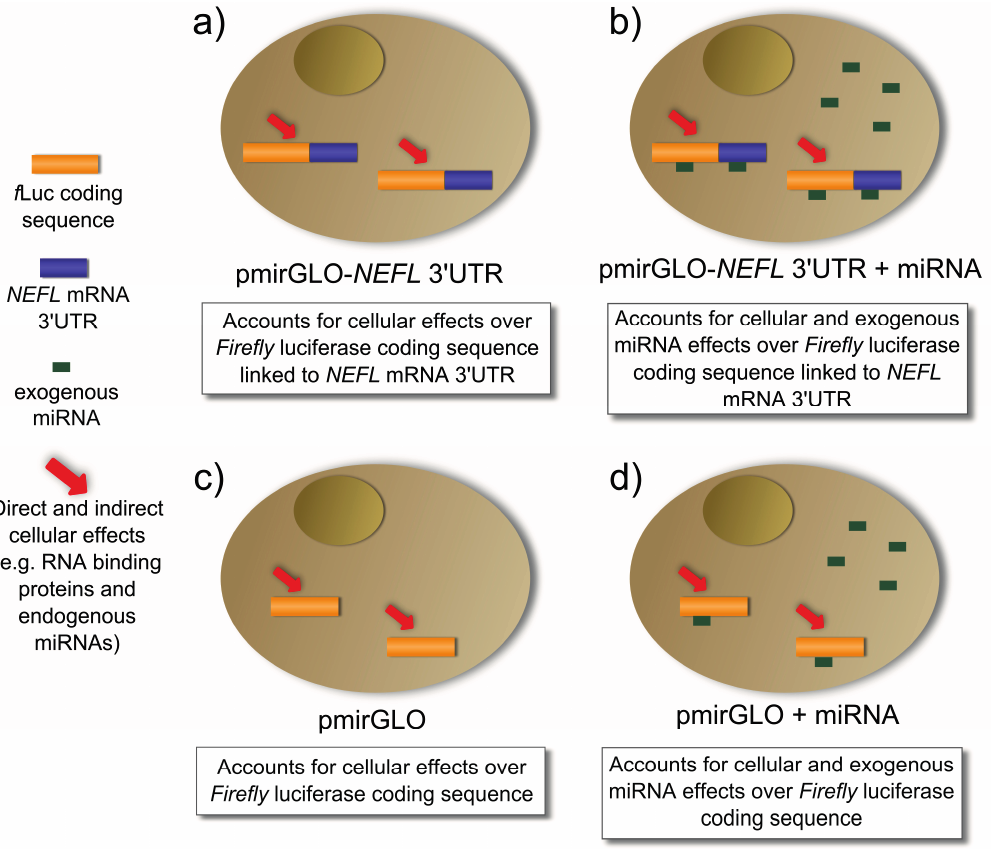
Figure 3. Cellular and exogenous miRNA effects regulating the luciferase activity in the reporter gene assay. ( a , b ) Cells transfected with luciferase with the NEFL mRNA 3'UTR; ( c , d ) Cells transfected with luciferase without